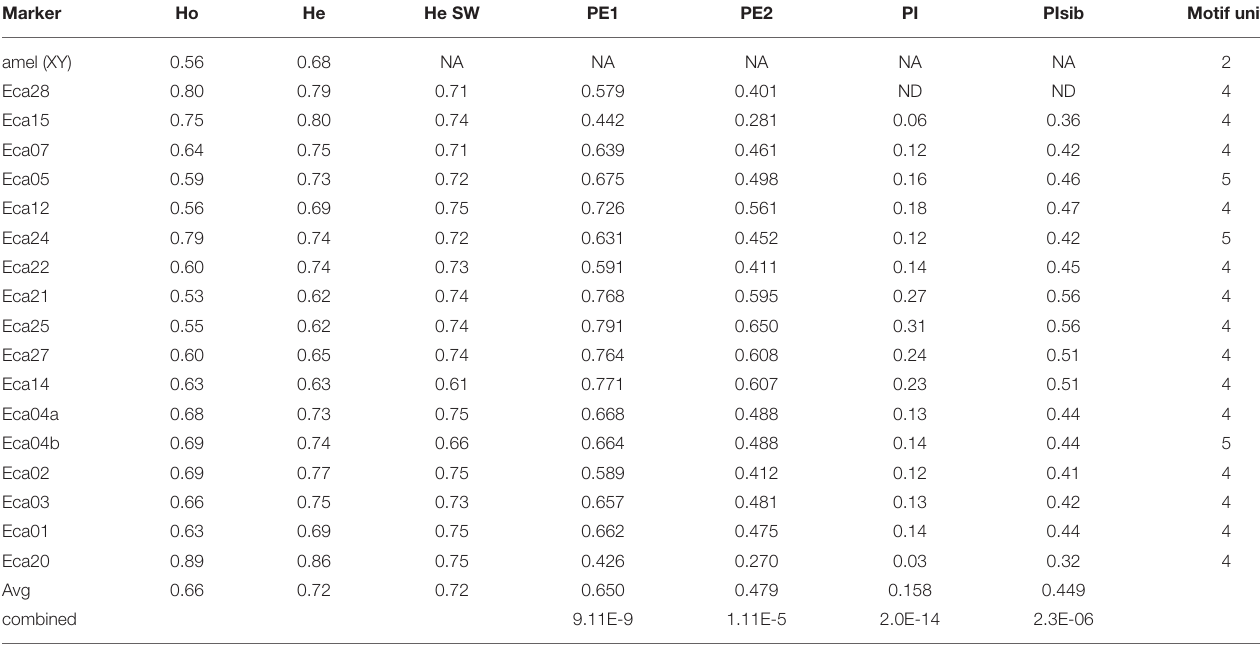
TABLE 2 | Genetic information for markers in the 17-plex panel. Marker Ho He SW PE1 PE2 PI PIsib Motif